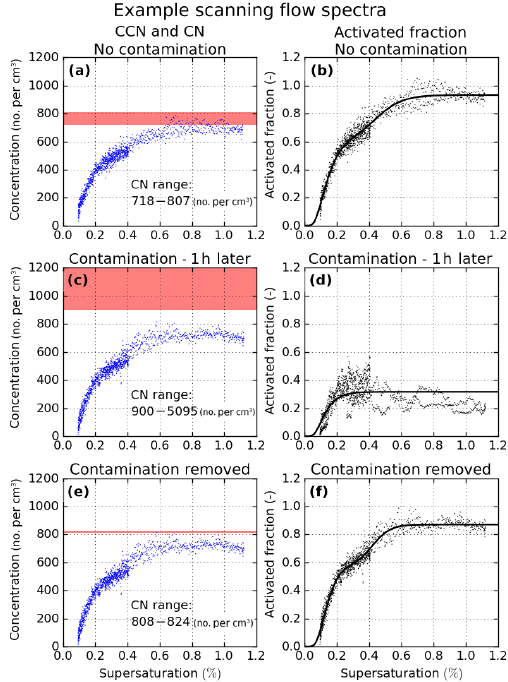
Figure 2. Example spectra measured by the sfCCN system for the same time period as in Fig. 1. (a) 1s CCN (blue) and the range of CN (red) concentration measurements for a single scan. (b) Acti- vated fractions for measured points in (a) along with a best-fit acti- vated fraction spectrum curve (black line). (c, d) As in (a, b) , but for a scan approximately 1h later that was contaminated by an intermit- tent local ultrafine mode; CN were observed as high as 5000cm − 3 . (e, f) The same spectra as in (c, d) , but after correction to remove the contamination mode; corrected CN concentrations are now similar to the range in (a)